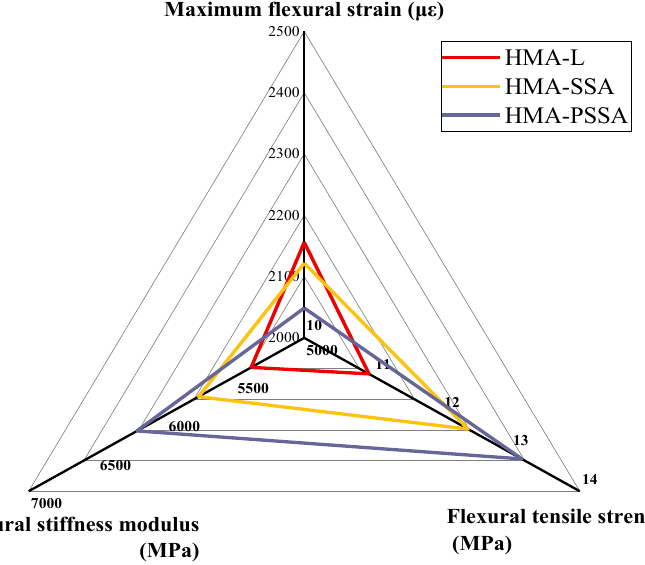
Figure 16. Low-temperature bending creep test results.